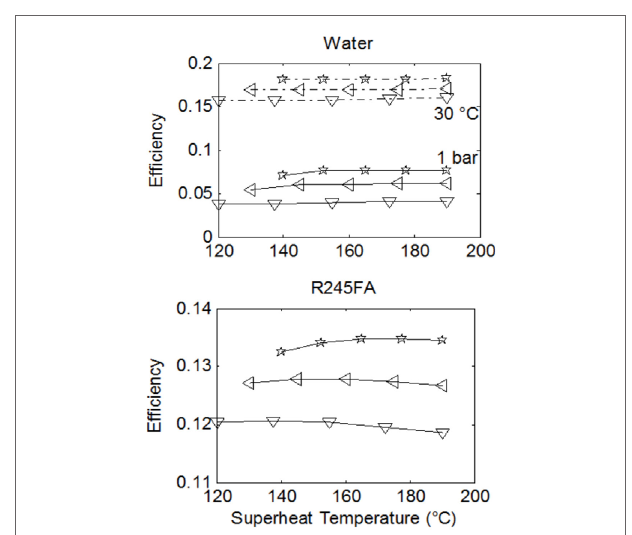
FiGURe 6 | Comparison of cycle thermal efficiencies from Rankine cycles with water and R-245fa over a range of maximum cycle temperatures, T 3 . Results correspond to the same conditions given in Figure 5